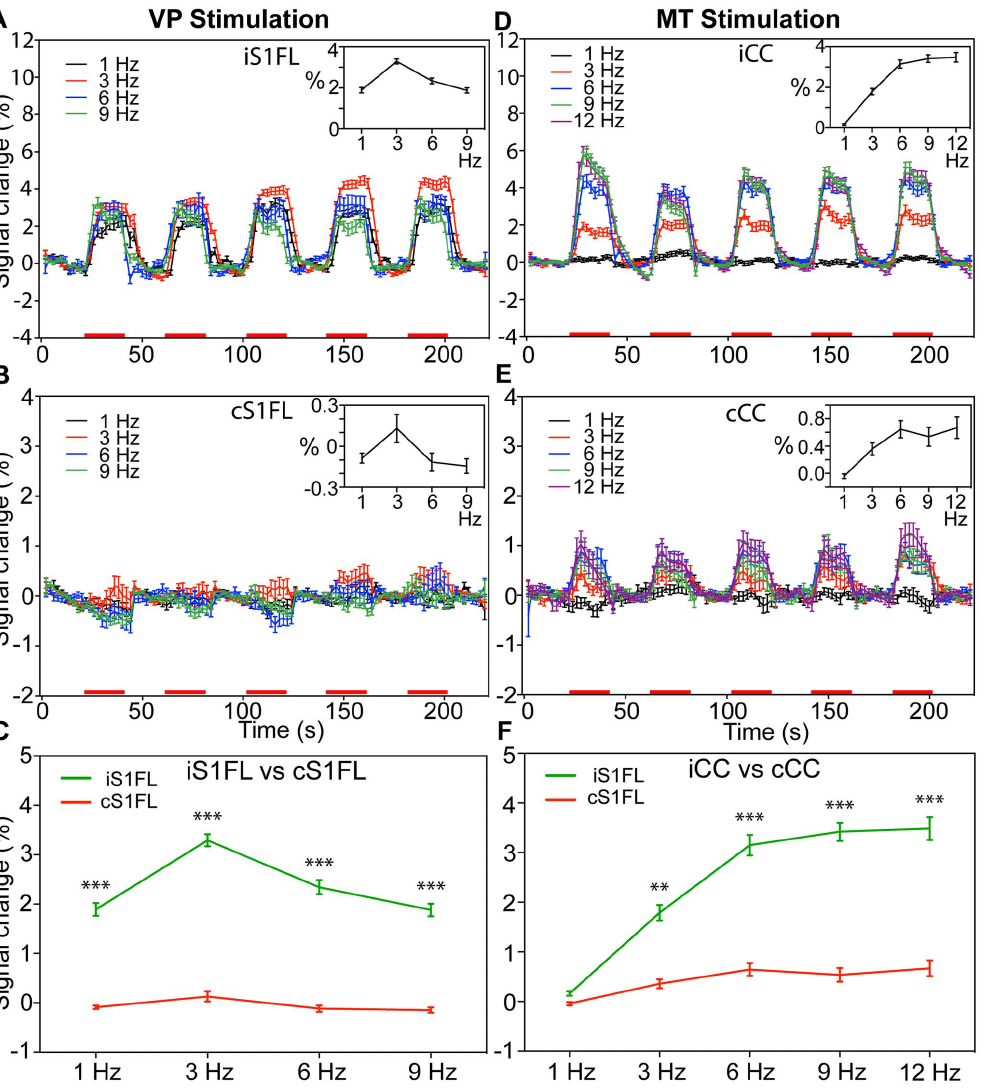
Figure 6. Comparison of BOLD signal changes in the cortical targets by various thalamic stimulation frequencies. Mean time course (mean 6 SEM, n=6) of BOLD signal changes within the iS1FL (A) and cS1FL (B) at four stimulus frequencies. Average time course (mean 6 SEM, n=6) of BOLD signal changes within the iCC (D) and cCC (E) at five stimulus frequencies. Red bars under the time axis show the periods of electrical stimulation. The mean BOLD response amplitude (average change, %) within the five stimulus blocks is shown against the stimulus intensity in the inset and enlarged in (C) and (F). (** p , 0.001, *** p , 0.0005, two-way ANOVA with Newman-Keuls posttest).